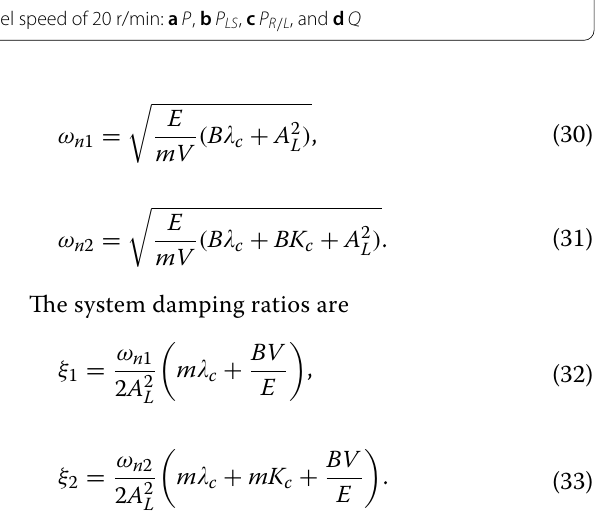
Figure 13 Experimental results under no load condition and steering wheel speed of 20 r/min: a P , b P LS , c P R / L , and d